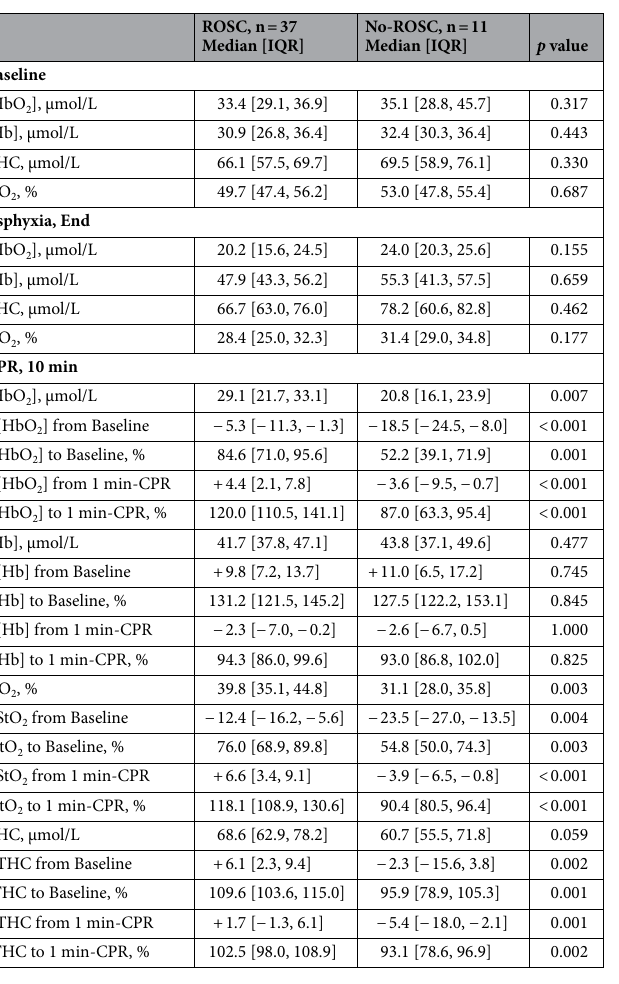
Table 2. Summary of cerebral hemodynamic parameters at baseline, end-of-asphyxia and at 10-min of CPR. [HbO 2 ], oxy-hemoglobin concentration; [Hb], deoxy-hemoglobin concentration; StO 2 , tissue oxygen saturation; THC, total hemoglobin concentration; Δ-prefix, absolute change; r-prefix, relative value compared to 100% at